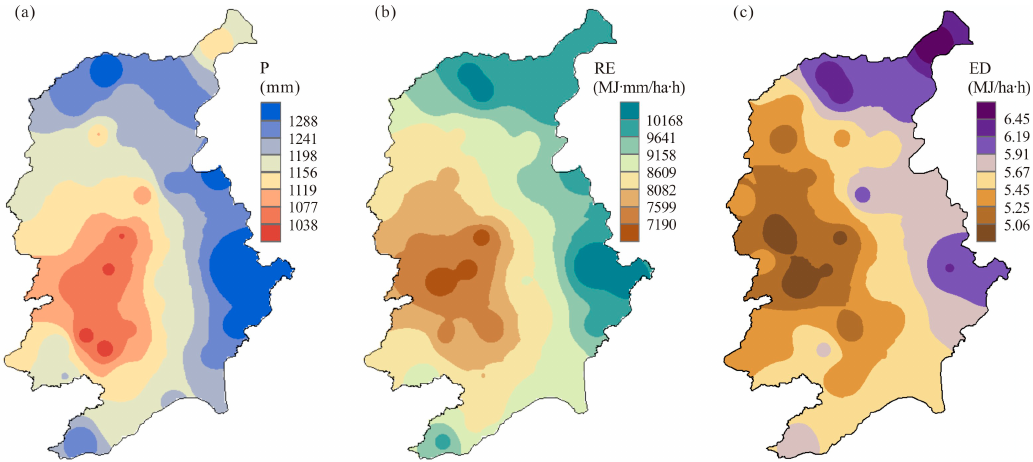
Figure 8. Comparison of spatial distribution of ( a ) annual erosive rainfall, ( b ) annual rainfall erosivity, and ( c ) erosivity density in the Ganjiang River catchment.